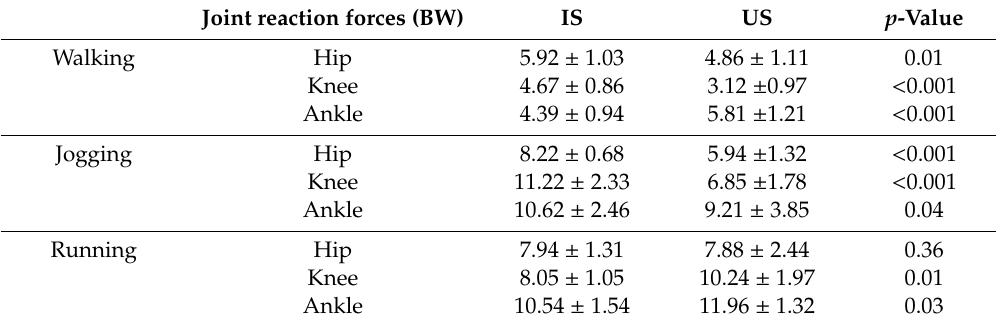
Table 6. The peak joint reaction forces of the involved side (IS) and the uninvolved side (US) during walking, jogging and running movements.